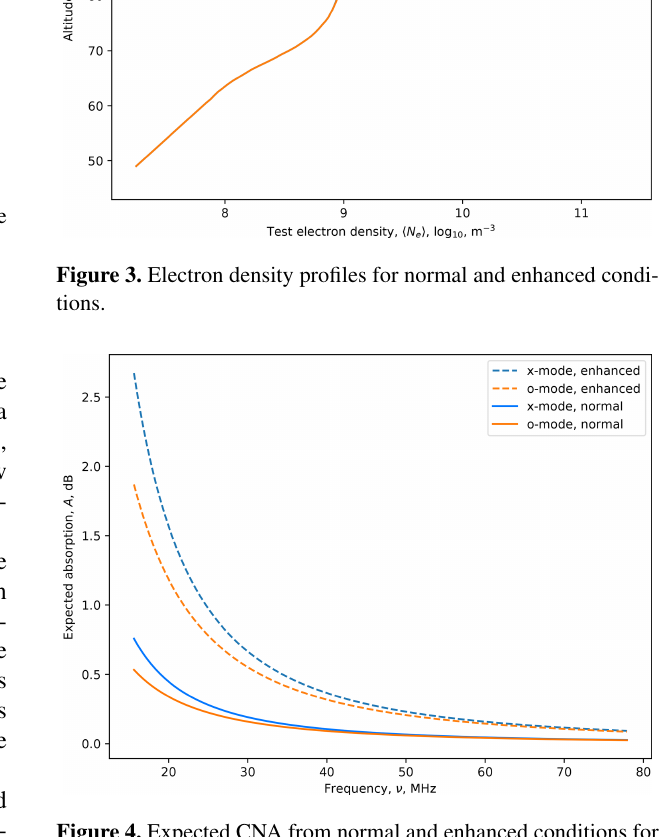
Figure 4. Expected CNA from normal and enhanced conditions for both x -mode and o -mode radio waves. The horizontal axis shows the observing radio frequency, ν = ω/ 2 π , in